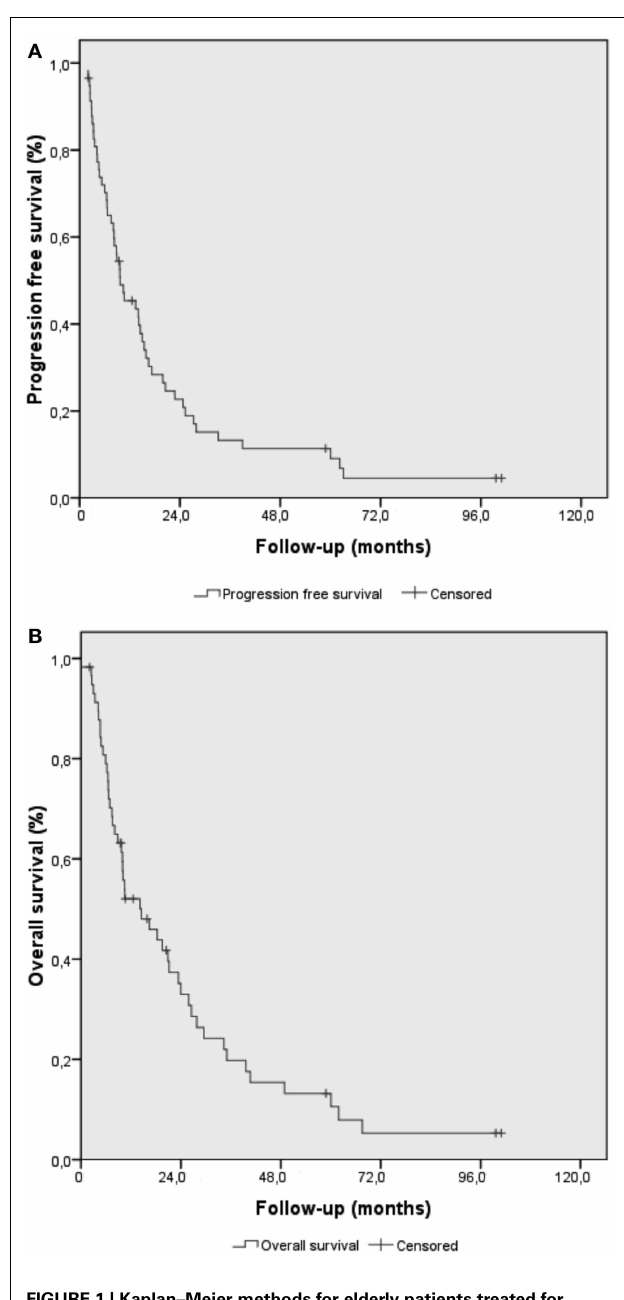
FIGURE 1 | Kaplan–Meier methods for elderly patients treated for esophageal and gastroesophageal cancer . (A) Progression-free survival curve (B) overall survival